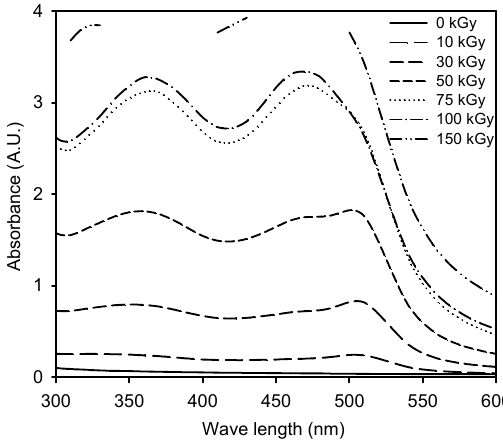
Figure 1. UV-Vis absorption spectra of Ag/PAAc